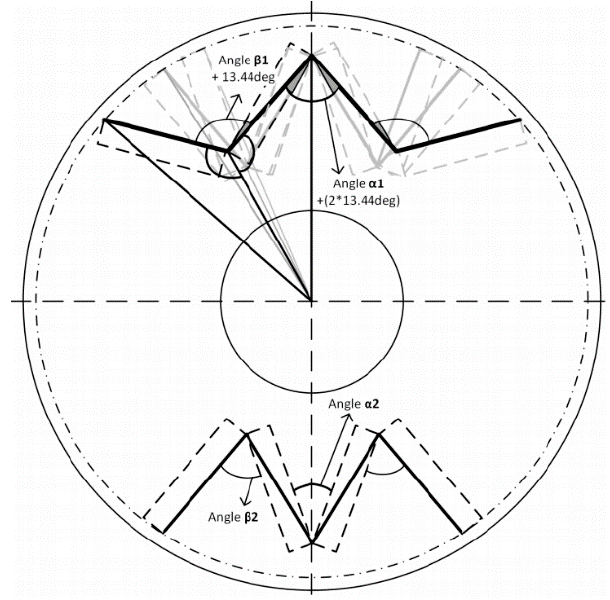
Figure 4. The PMSG parametrized rotor design space limitation.